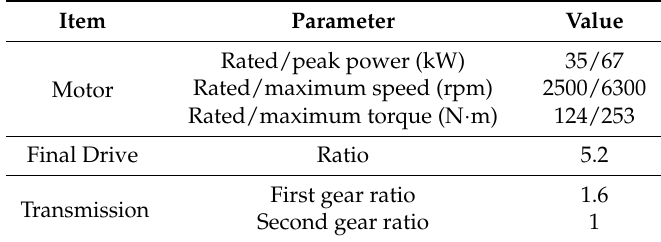
Table 5. Basic parameters of the single-motor drive powertrain system (SMPS).